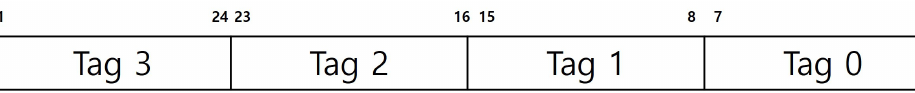
Figure 4. Encoding of the branch tag register .